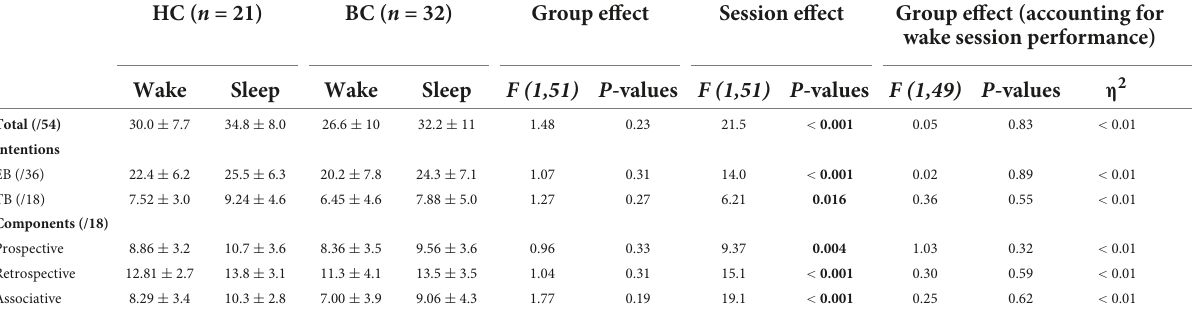
TABLE 4 Prospective memory (PM) performances during the wake and sleep sessions (mean ± SD) and analyses of the group and session effects. HC ( n = 21) BC ( n = 32) Group effect Session effect Group effect (accounting for wake session